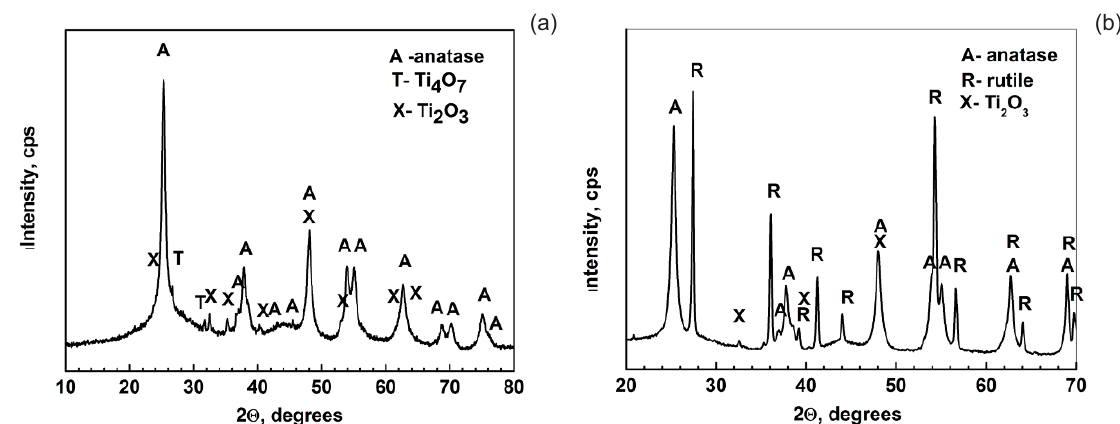
Figure 2. XRD of composite TiO